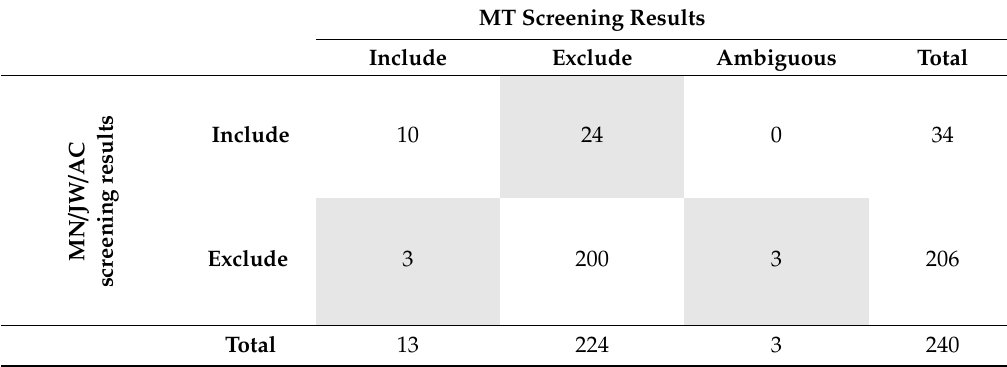
Table 2. Cross-tabulation of MT’s screening results and the results from MN / JW / AC’s screening of a 10%